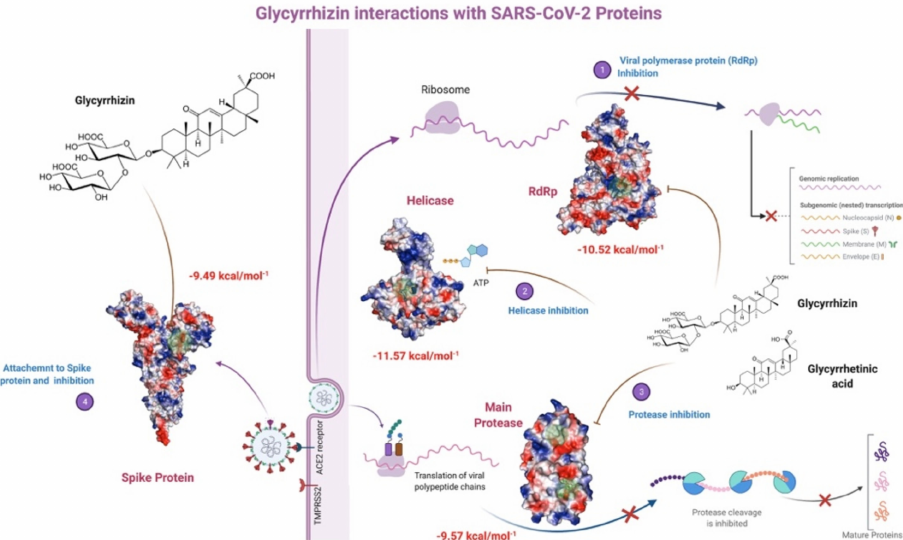
Figure 14. Glycyrrhizin interactions with SARS-CoV-2 proteins (prepared with bio